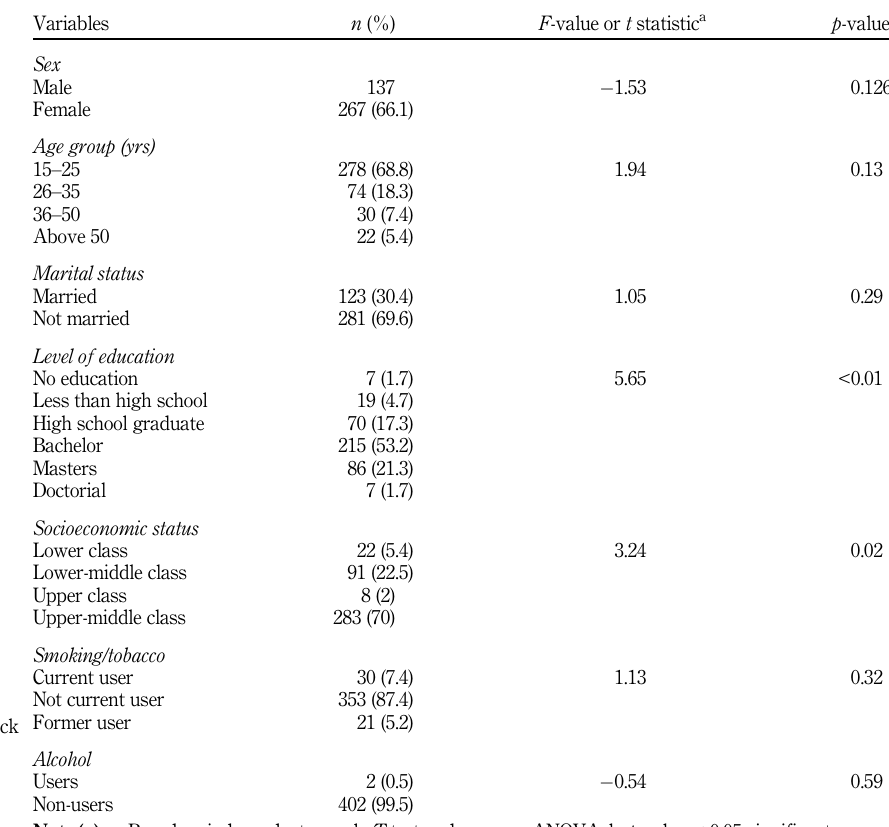
Table 1. Bivariate analysis between head and neck cancers ’ knowledge scores and demographic characteristics of population ( n 5